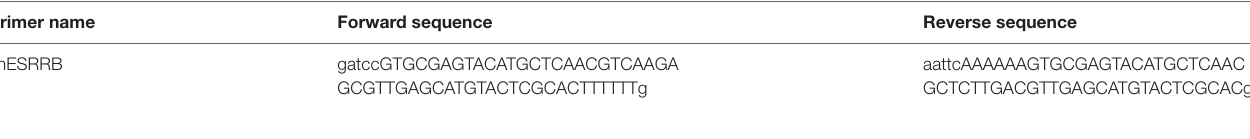
TABLE 2 | shRNA primers used in this